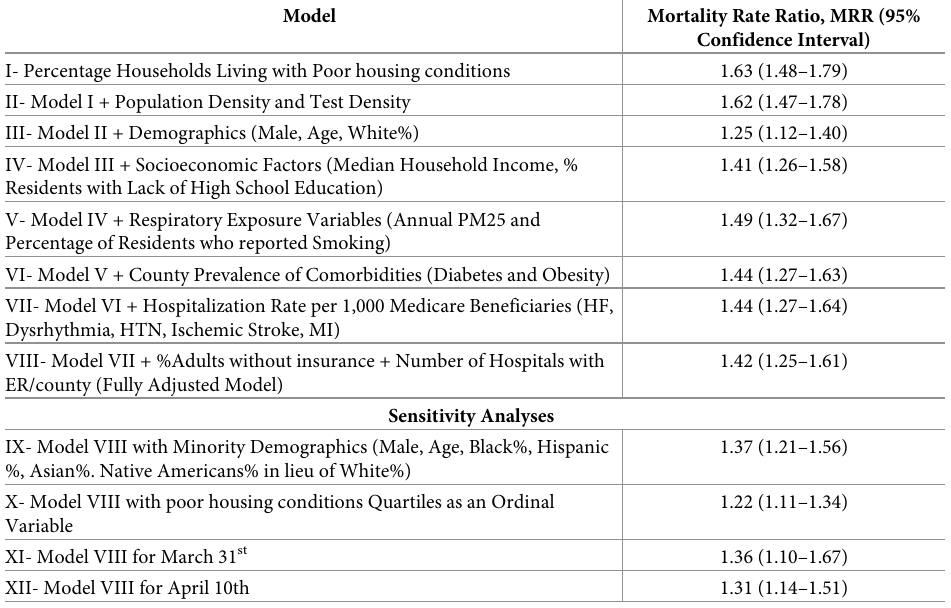
Table 3. Relative risk of county Covid-19 mortality as of April 21, 2020 related to percent households with poor housing